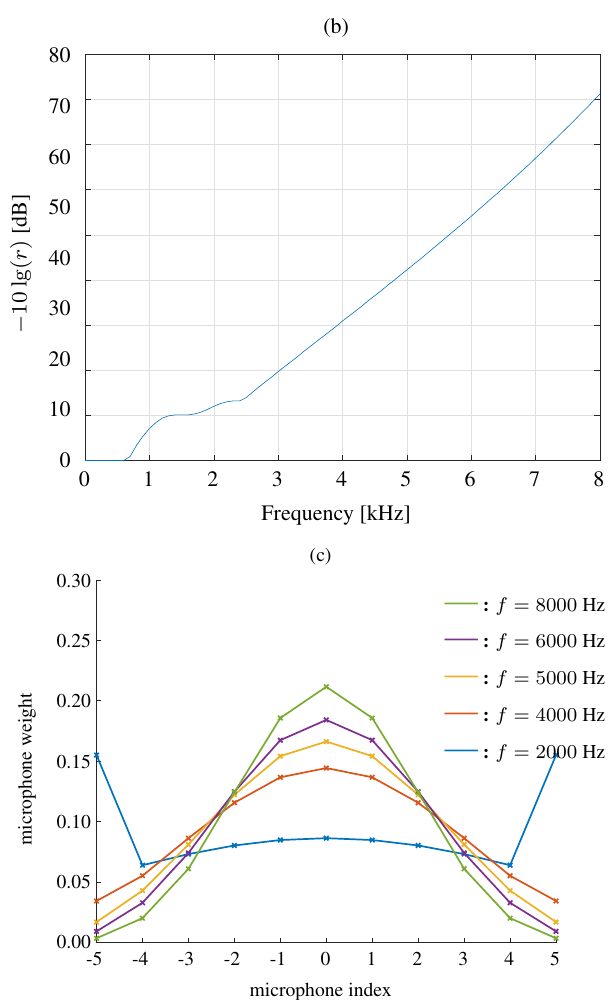
Figure 13. Constant beamwidth beamforming using the Chebyshev window-I method: ( a ) constant beamwidth beampattern, ( b ) the parameter r , ( c ) the weights of microphones for different frequency bins. The beamwidth is fixed to 40 ◦ , M = 11, δ = 3.5 cm.